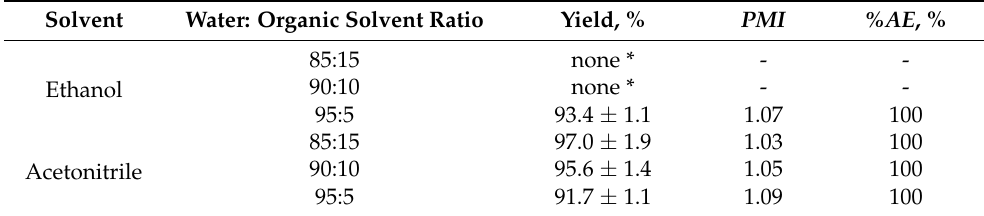
Table 1. Results of synthesis.